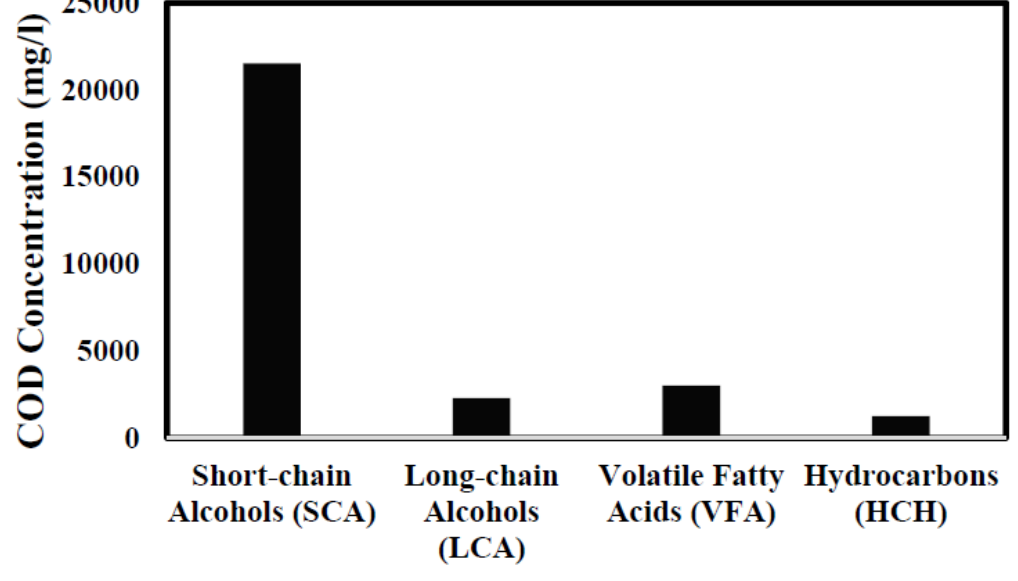
Figure 2. F–T wastewater composition with COD Figure 2. F – T wastewater composition with COD concentration.